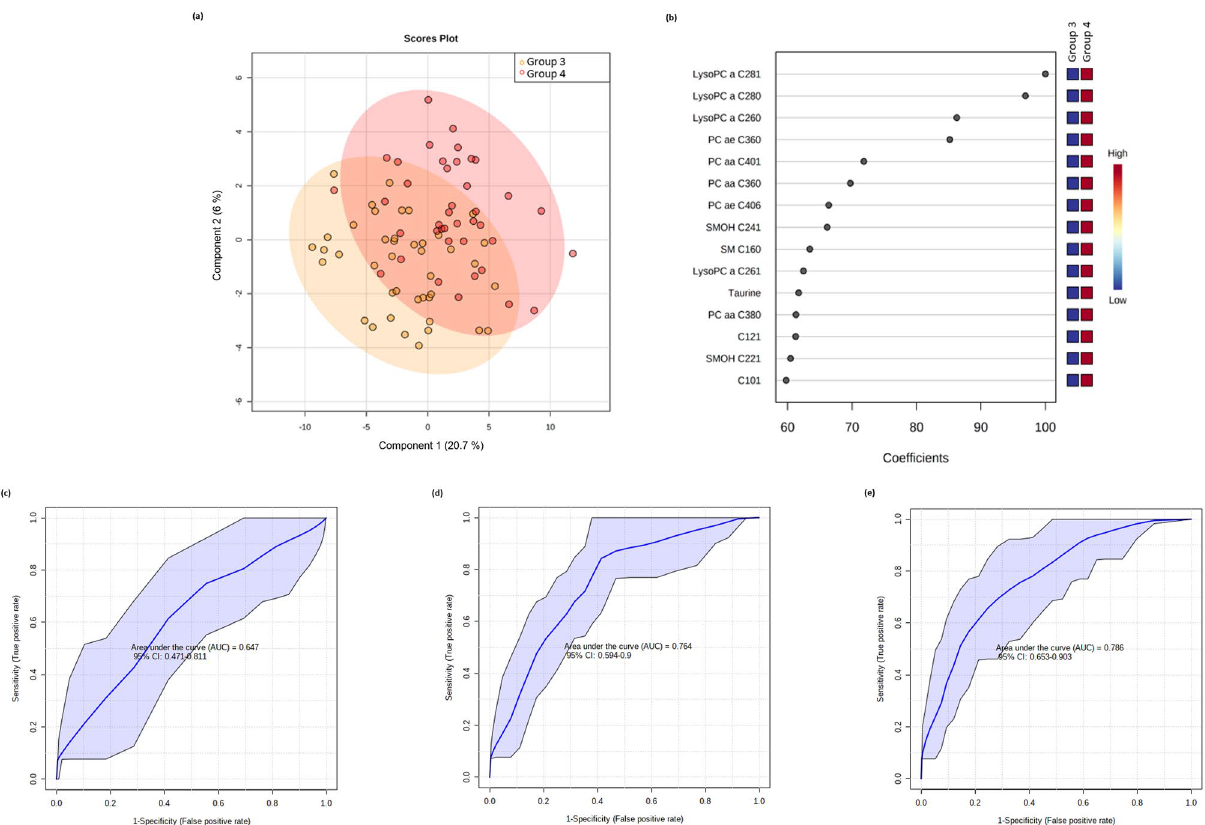
Figure 3. Multivariate analysis from plasma metabolome profile of G3 versus G4 patients. ( a ) Score scatter plot based on the PLS-DA models to explain the diagnosis (orange for G3 and red for G4; ( b ) rank of the different metabolites (the top 15) identified by the PLS-DA according to the VIP coefficient on the x-axis. The most discriminating metabolites are shown in descending order of their coefficient scores. The color boxes indicate whether metabolite concentration is increased (red) or decreased (blue) in G3 vs G4; ( c ) ROC curve of the demographic/clinical data model; ( d ) ROC curve of the metabolite-only model; ( e ) ROC curve of the metabolite + demographic/clinical data model. The figures were drawn via MetaboAnalyst software v 4.0 (https:// www. metab oanal yst.